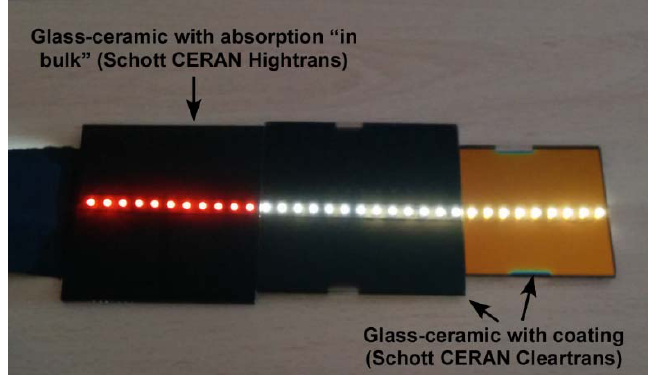
Figure 8. Visualization of white LEDs across black glass ‐ ceramic (left) and different transparent glass ‐ ceramics with semitransparent decorative coatings: navy/black (center) and yellow (right).